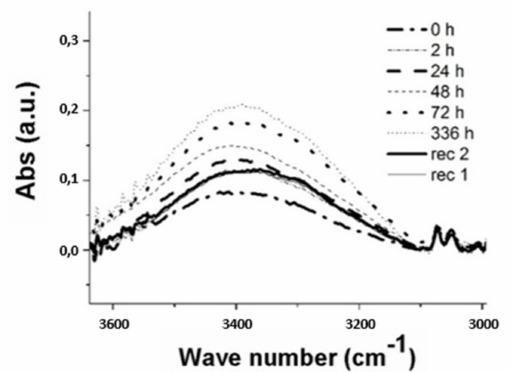
Figure 8. IR spectrum of the -OH signal for samples coated by Silicopon at di ff erent ageing time.